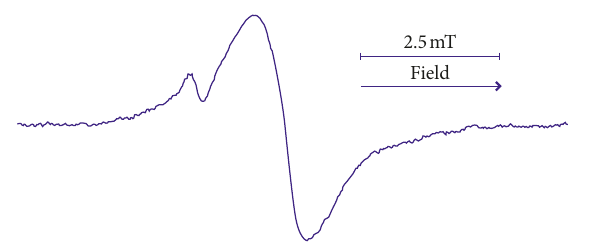
Figure 10: ESR spectrum of spin probe 2 in blood